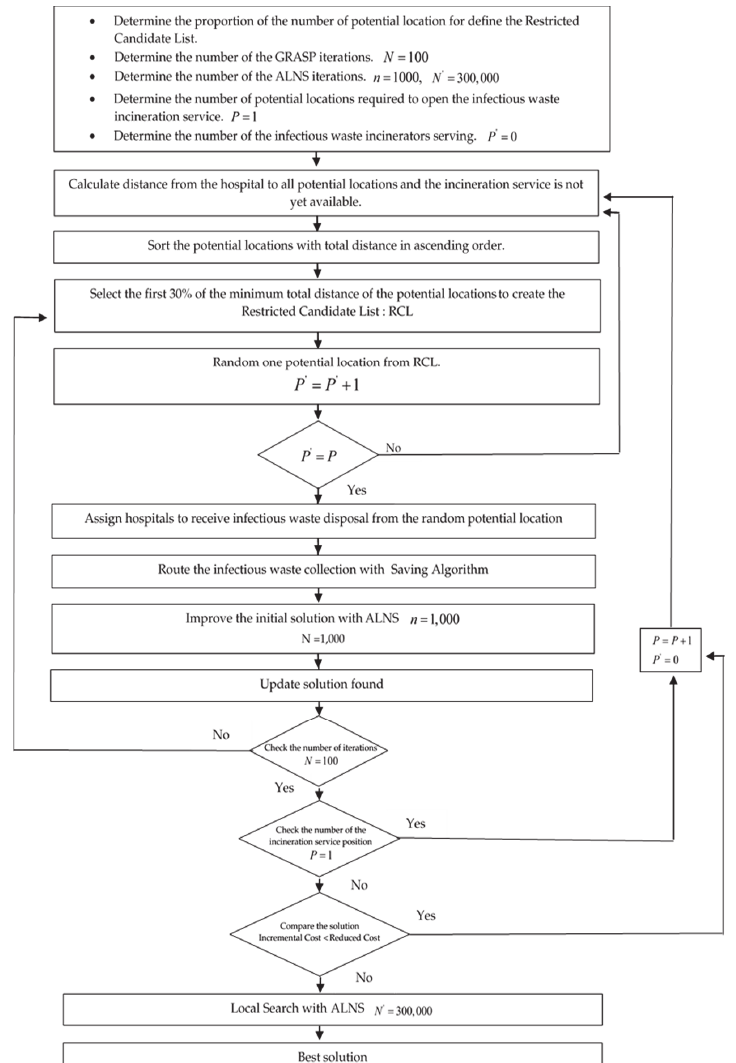
Fig. 2. The structure of the Greedy Randomized Adaptive Large Neighborhood Search Procedure